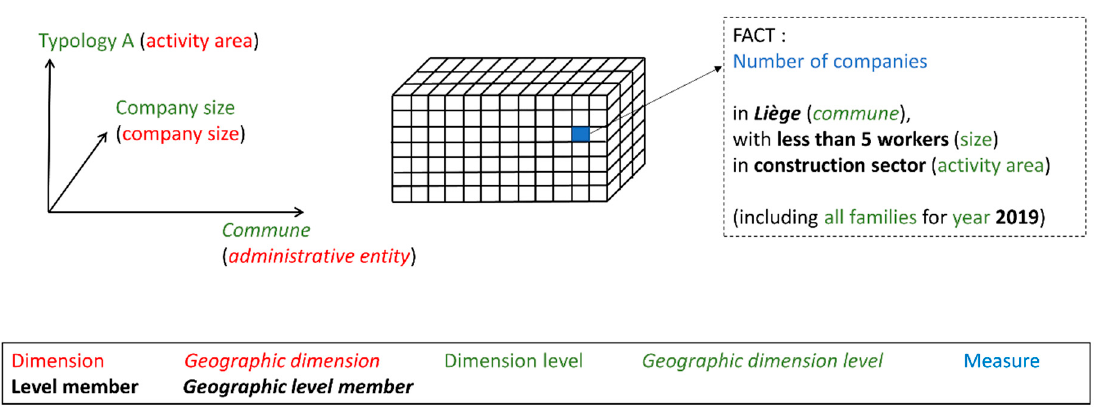
Figure 6. A data cube instance.